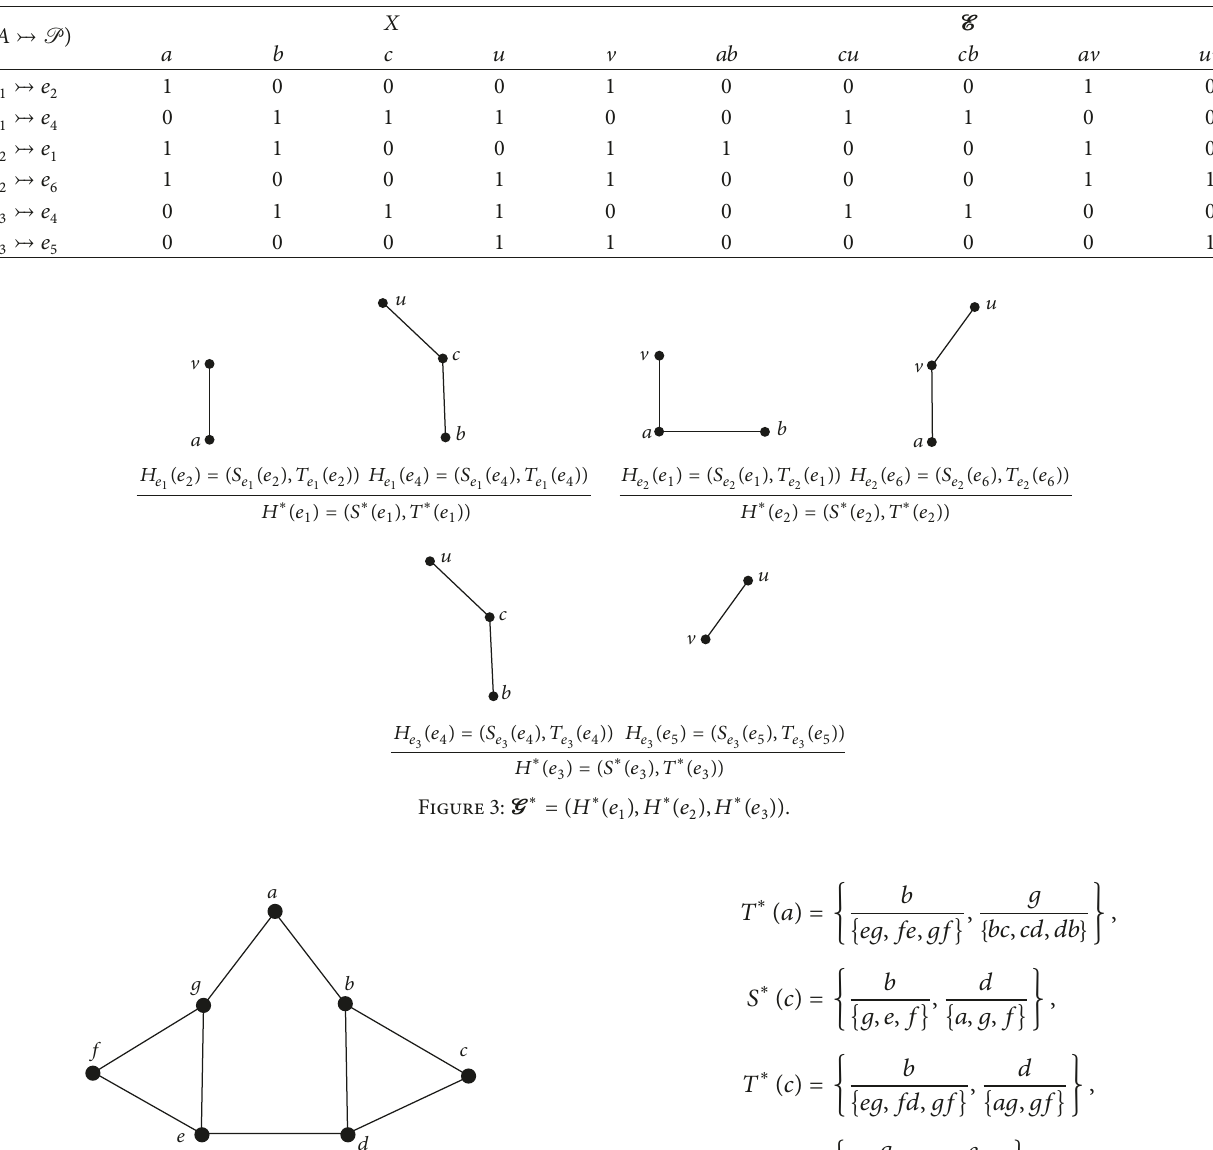
Table 1: Tabular representation of a type-2 soft graph.